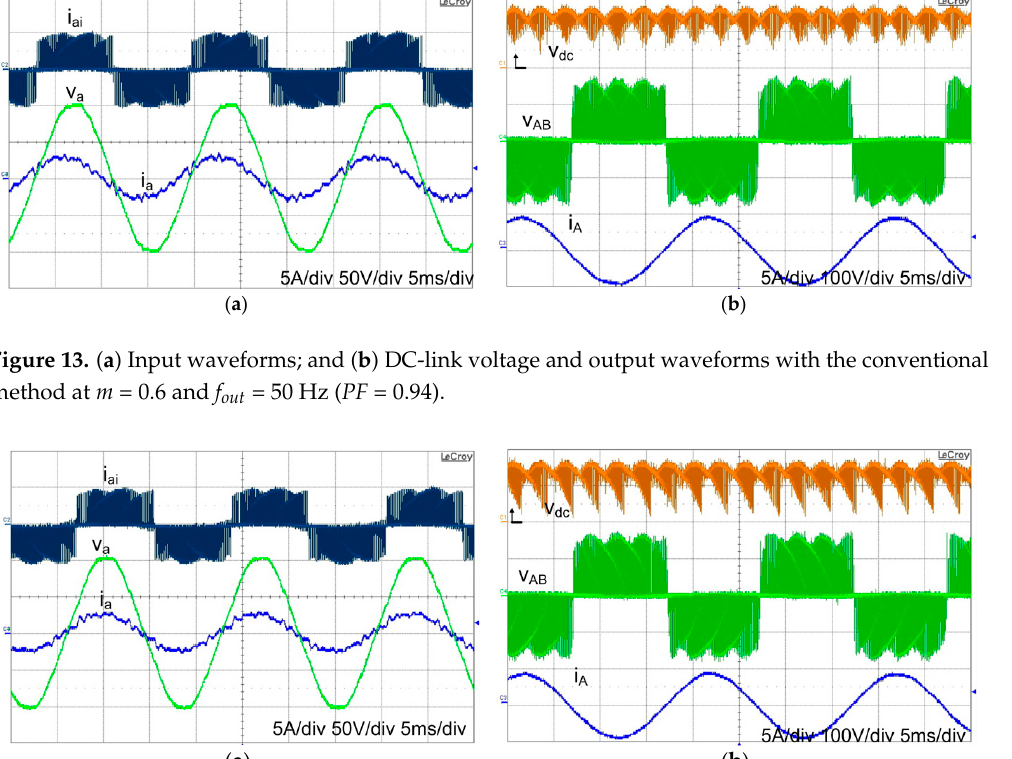
Figure 14. ( a ) Input waveforms and ( b ) DC-link voltage and output waveforms with the proposed method at m = 0.6 and f out = 50 Hz ( PF = 1.0).